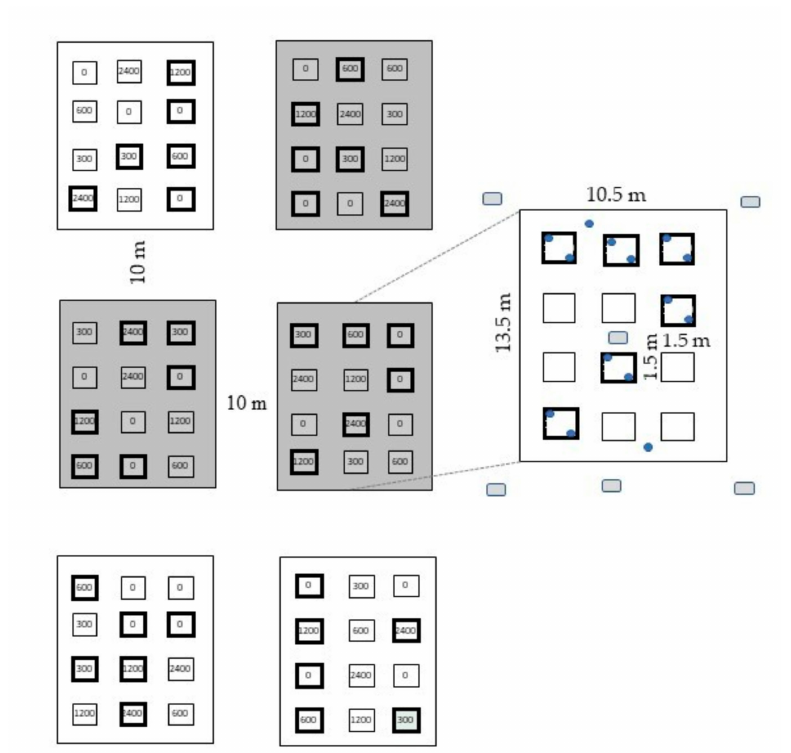
Figure A1. Experimental design showing the arrangement of the six blocks. In three blocks (grey) intraspecific competition and in the other three blocks (white) interspecific competion was initiated. Each block consist of 12 plots where half of them is surrounded by a plastic frame to prevent the acces of seed predators. Seed predators were trapped using Pitfall and Sherman life traps. In each plot we sowed a different density of E. crus-galli indicated by the number 0, 300, 600, 1200, 2400 seeds m − 2